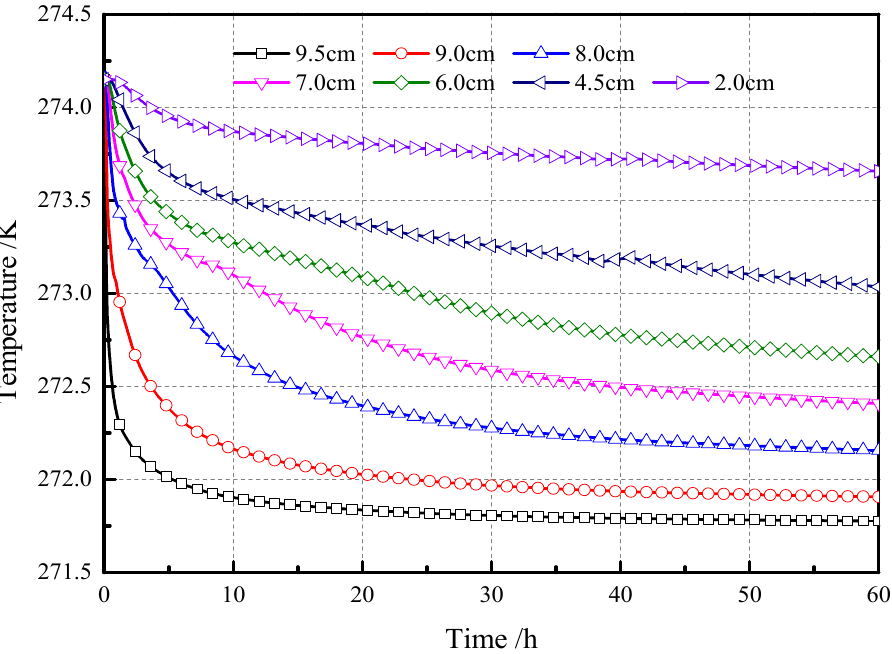
Figure 5. The temperature evolution curve of the soil column with different heights. The temperature distributions along the height of the soil column in case 2 are presented in Figure 6. The dotted line corresponds to 273.15 K. The temperature tends to be linear outside of the dotted line region. Near the temperature for 273.15 K, the change of the temperature gradient is mainly caused by the release of latent heat from the phase transition of pore water. The temperature fields at different times in case 2 are shown in Figure 7.